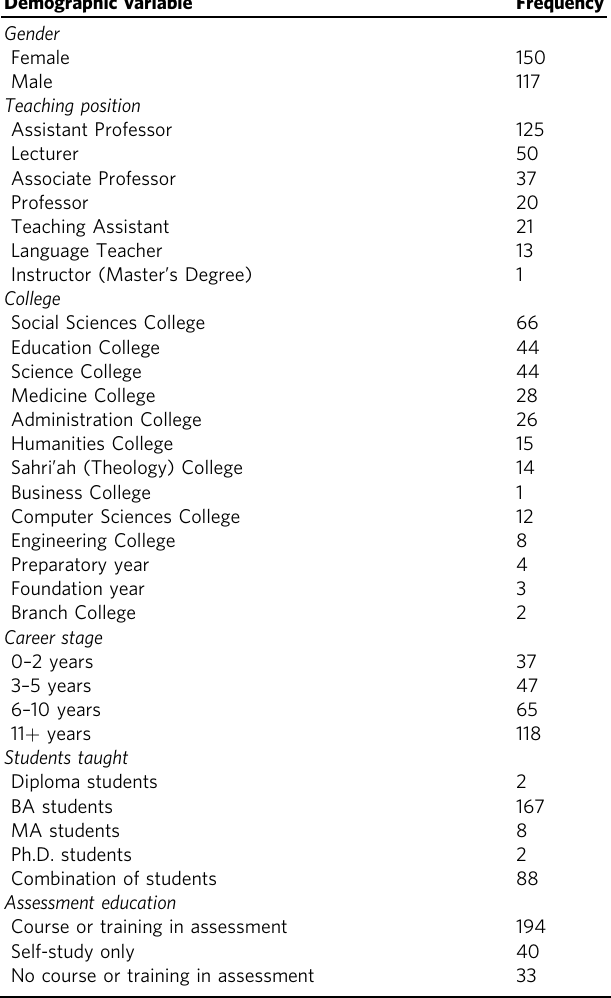
Table 1 Participant demographics ( N =